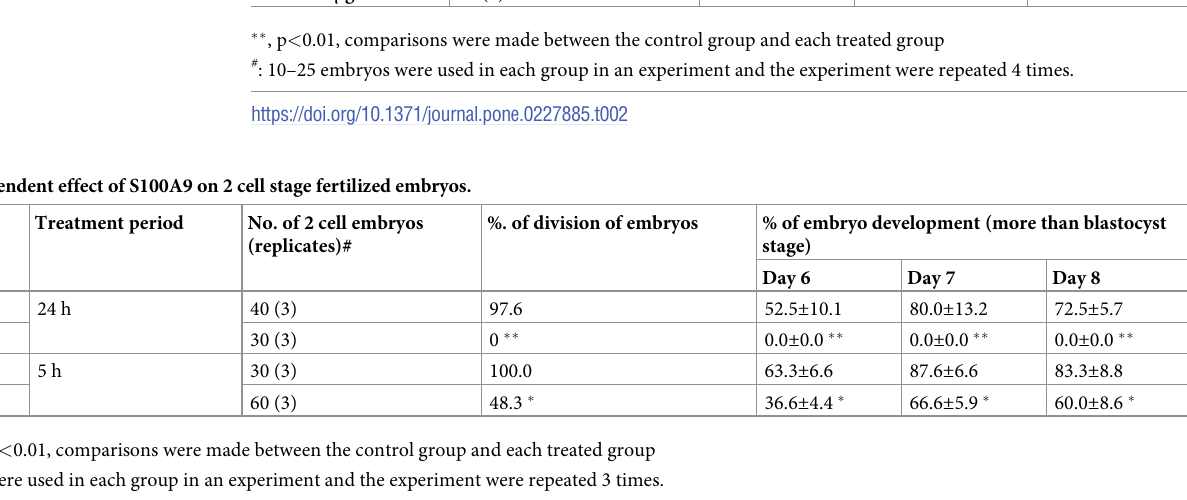
�� , p < 0.01, comparisons were made between the control group and each treated group # : 10–25 embryos were used in each group in an experiment and the experiment were repeated 4 times.